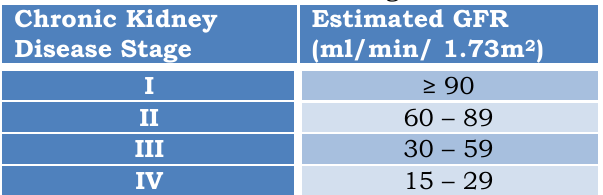
Table 1. Definitions of CKD stages based on